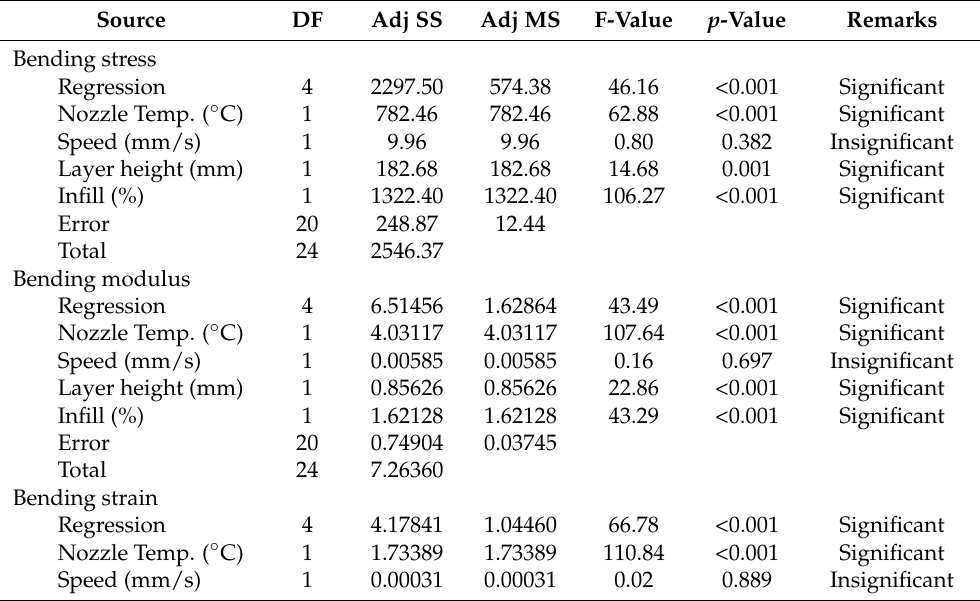
Table 8. ANOVA analysis for